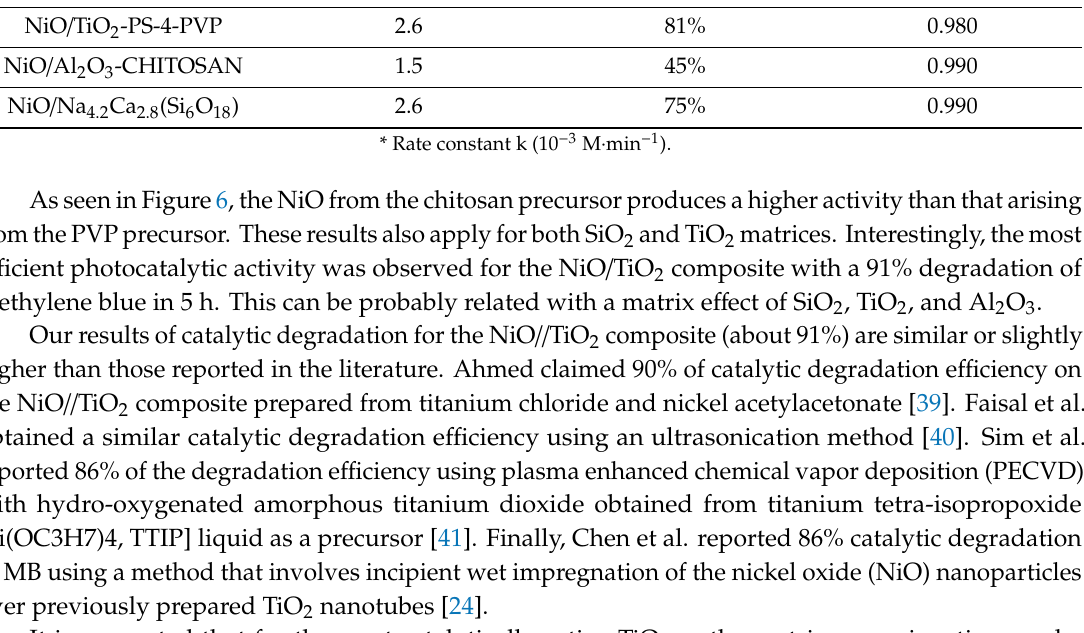
Figure 8. Variation of both E g and λ max with the different matrices.